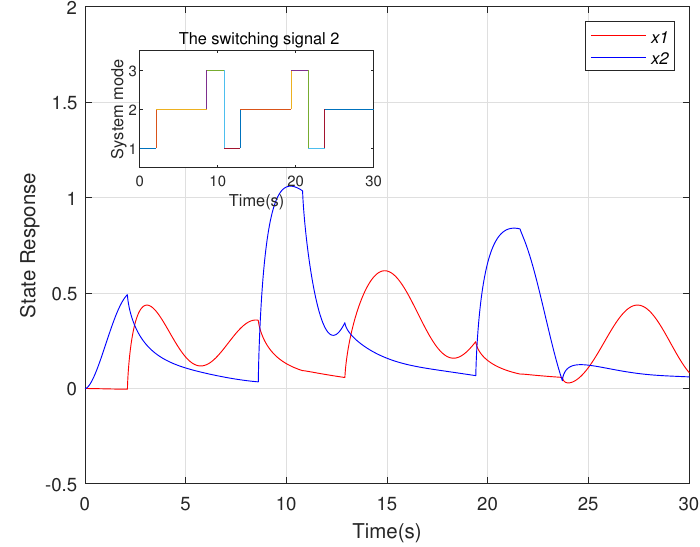
Figure 2. The state response of the system under the signal